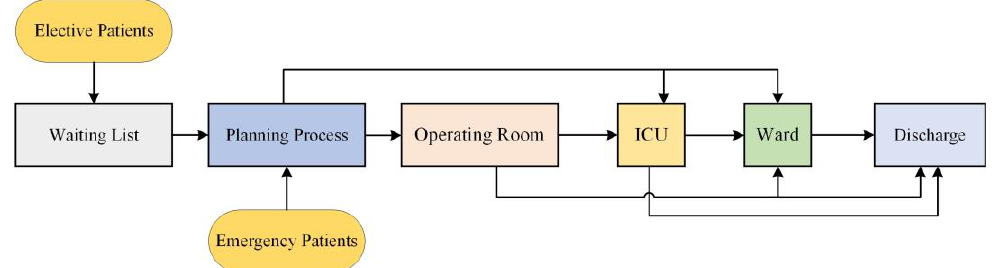
Figure 1. Patient flow considered in this paper. It can be seen from Figure 1 that the patients arriving in the OR have the possibility to move into the ICU or the wards or can be discharged after treatment in the OR; the patients arriving in the ICU can move into a ward or can be discharged after treatment in the ICU. Current research considered the multi-level planning of patients on critical resources. The process considered in the current research for the multi-level planning of critical resources is presented in Figure